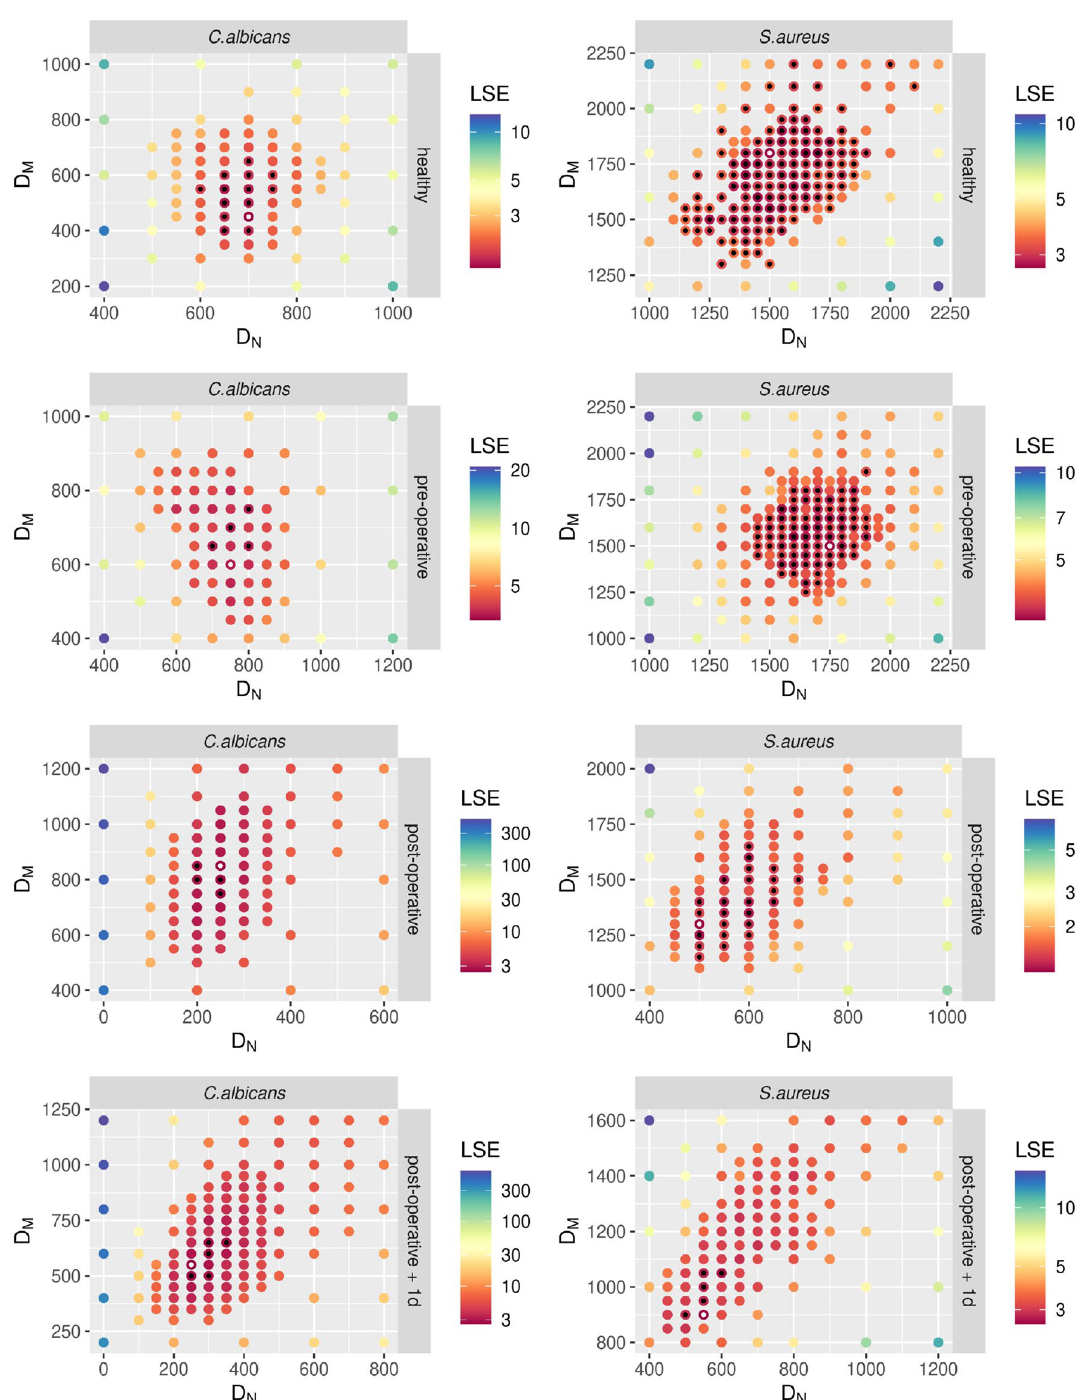
Figure 5. Results of fitting the agent-based model (ABM) to the experimental data from C. albicans and S. aureus infection using the method of adaptive regular grid search. The parameter space is shown for fitting the ABM to experimental data, where blood samples from healthy donors and HLM patients before surgery (pre-operative), immediately after surgery (post-operative) and one day after admission to intensive care (post-operative + 1d) were infected with either C. albicans (left column) or S. aureus (right column). Colors of −→ −→ p (cid:30) for each parameter set p = ( D N , D M ) . The optimal the points refer to the weighted least squares error E (cid:31) parameter set is marked with a white dot. All parameter sets with a mean LSE that lies within the SD of the optimal parameter set are marked with a black